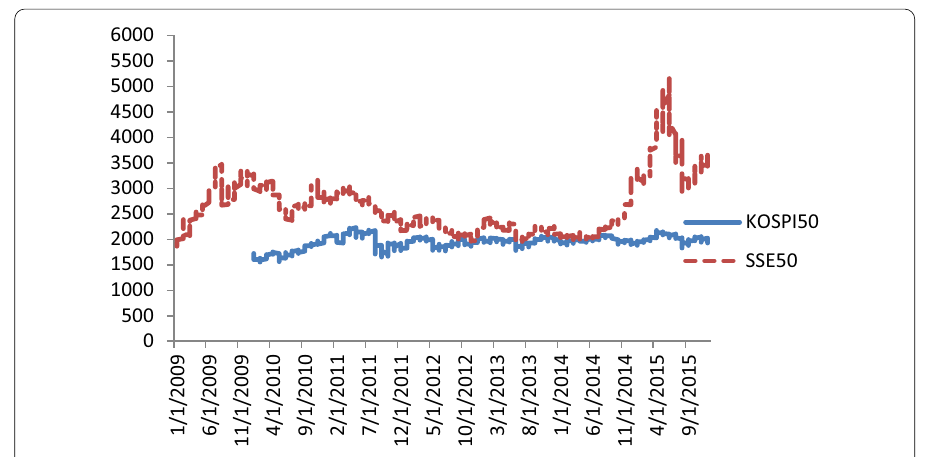
Fig. 1 Trends of the KOSPI 50 and SSE 50 indices from 2009 to